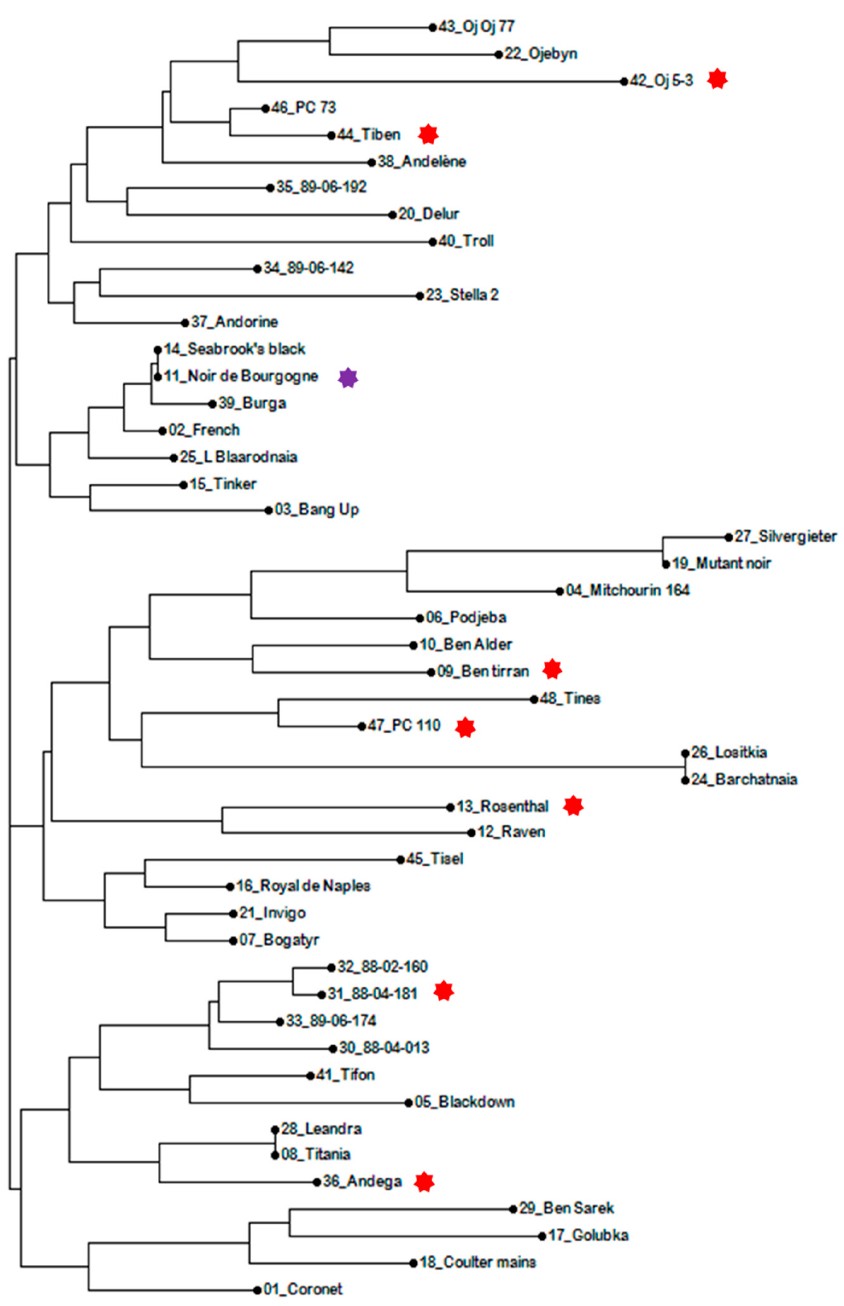
Figure 7. Phylogenic Tree showing similarities of some varieties used in the study. Darwin software, unweighted Neighbor joining method, using allelic data from eight SSR markers. Noir de Bourgogne cultivar was indicated with a purple star; the red stars indicated the seven other parental varieties involved in the study.